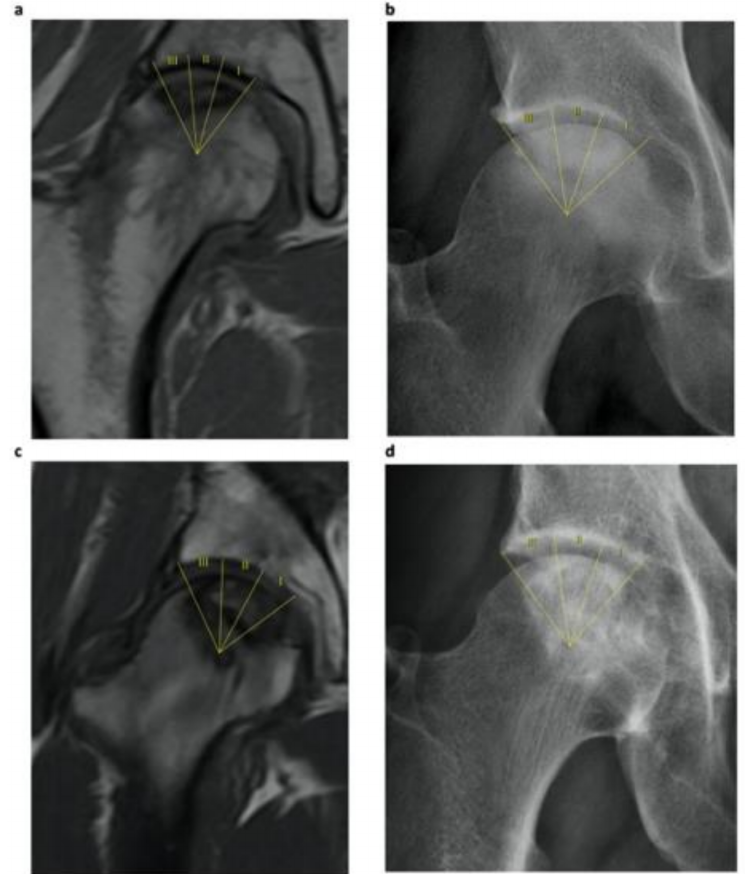
Figure 2. Coronal location of the lesion in the weight-bearing area through the 2001 system, compar- ing T1-coronal MR with AP radiograph of two cases. In case 105, lesion ( a ) was classified as C2 as it occupied three thirds of the weight-bearing area and extended laterally to the acetabular edge; while lesion ( b ) was classified as C1, not extending further than the acetabular edge. In case 202, lesions through both imaging techniques in ( c ) and ( d ) were classified as C1. I, II, III: Weight-bearing area